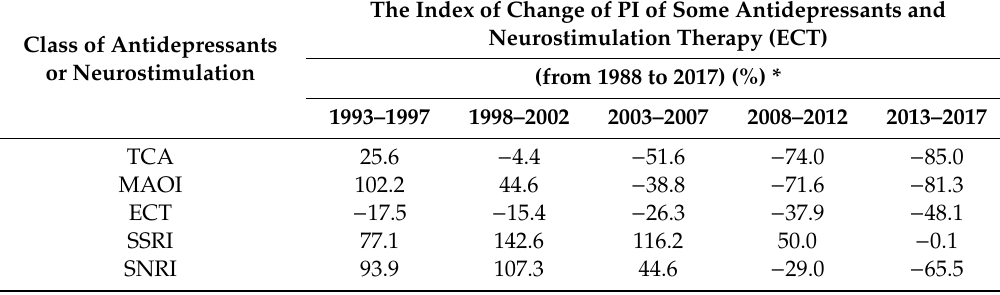
Table 5. The index of change of popularity index for di ff erent classes of antidepressants and ECT. The Index of Change of PI of Some Antidepressants and Neurostimulation Therapy Class of Antidepressants or Neurostimulation